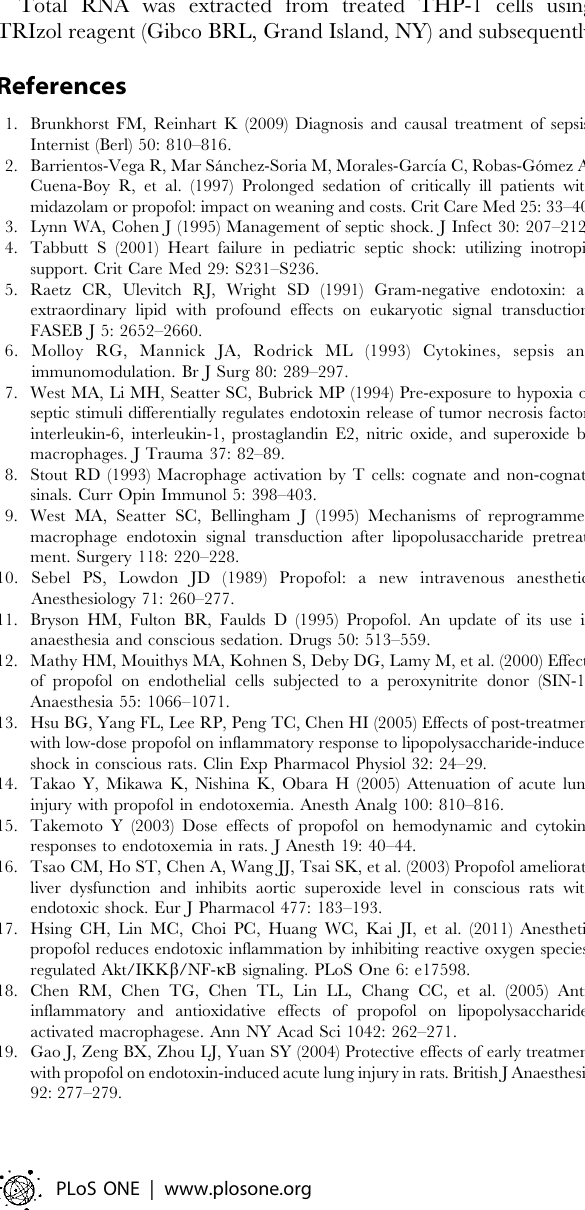
(Table 2). PCR products were visualized on 2% agarose gels